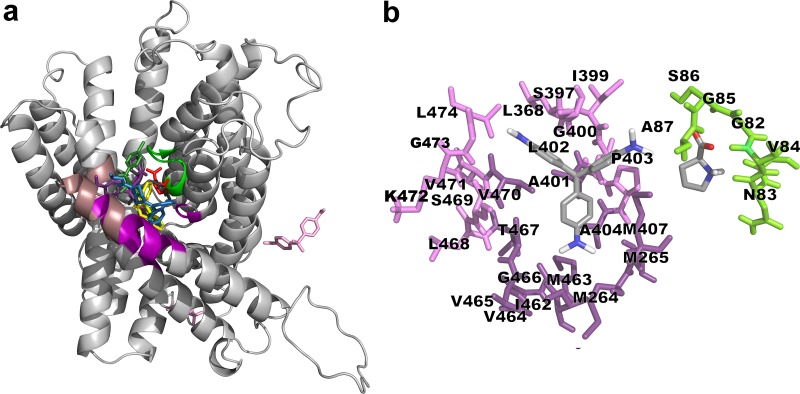
Binding poses suggested by molecular docking between proline, crystal violet and its chemical analogues with proline permease TcAAAP069.(a) Homology modelled TcAAAP069 (represented as cartoon) highlighting the predicted interaction sites of proline (PRO site, green) and crystal violet (CV site, violet; and dark shadowed-violet indicates the hydrophobic “hot-spot”). The predicted binding poses of proline (red), CV (violet), loratadine (blue), cyproheptadine (yellow), olanzapine (dark-grey), clofazimine (green) and dapsone (pink) are shown in the figure. (b) Detail of the residues predicted to interact with CV (right side) and proline (left side).